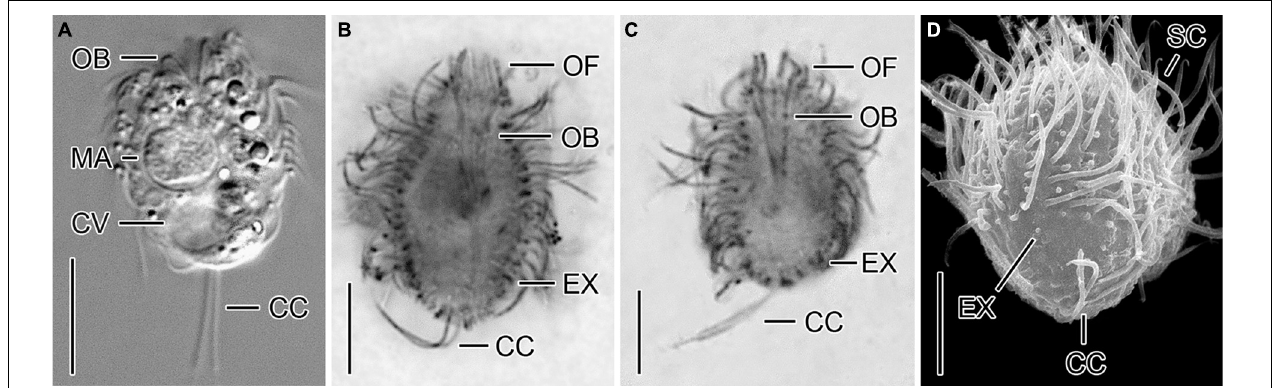
FIGURE 4 | A cryptic species tentatively identified as Urotricha pseudofurcata , i.e., specimens of strain CIL-2019/3 from Lake Zurich in vivo (A) , after protargol staining (B,C) , and in the scanning electron microscope (D) . (A–C) Longitudinal optical sections. (D) Oblique posterior polar view. CC, caudal cilia; CV,